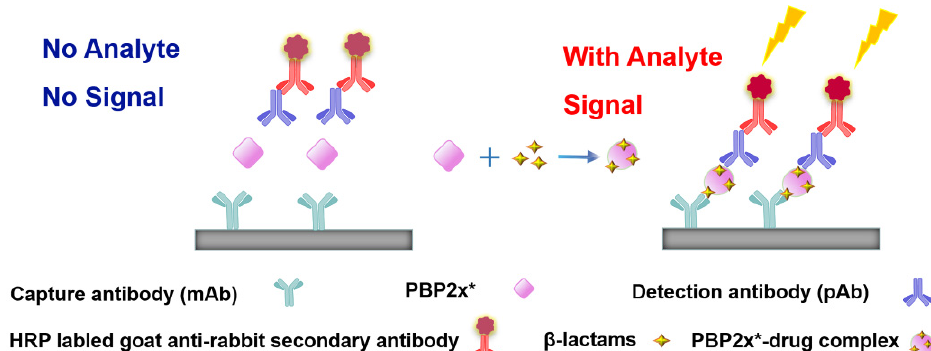
Figure 2. Schematic representation of sandwich immunoassay for small-molecule detection based on PBP2x*.